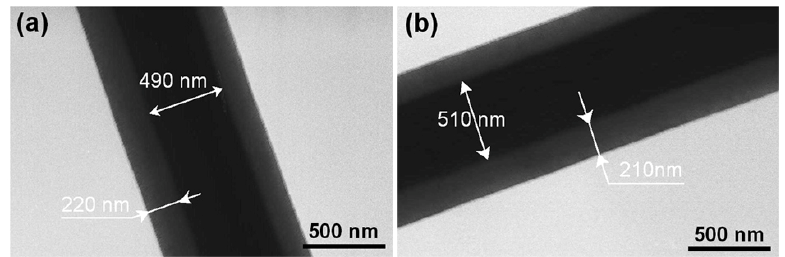
Figure 3. TEM images of the core-shell nanofibers: ( a ) F3 and ( b ) F4.